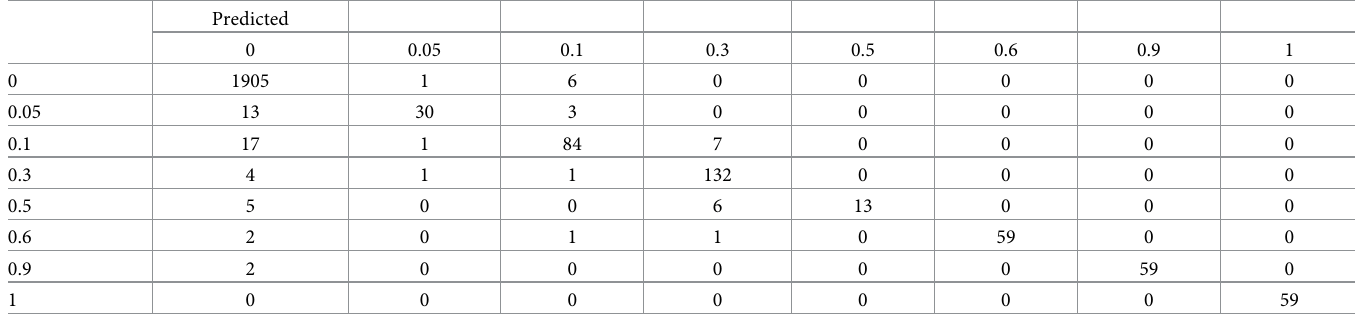
Table 1. Multinomial logistic regression on full data set without separating into training and testing sets. Data was classified with respect to pathology gradings of the region the spectra were acquired from. Predicted